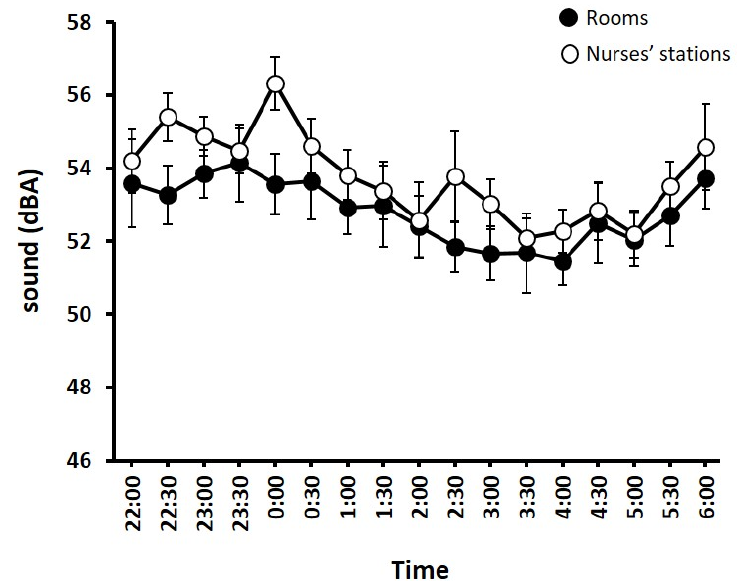
Figure 2. Sound levels (dB) in rooms (closed circles) and nurses’ stations (open circles) overnight. Error bars are SEM.